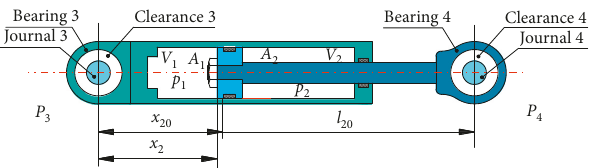
Figure 2: Model of a hydraulic cylinder with clearance on the